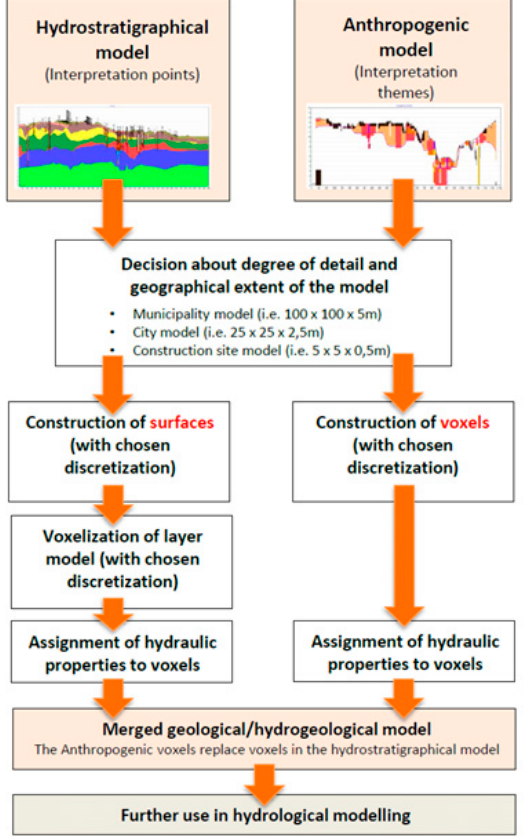
Figure 9. Workflow for the combined geological and anthropogenic model [25] of the urban area.